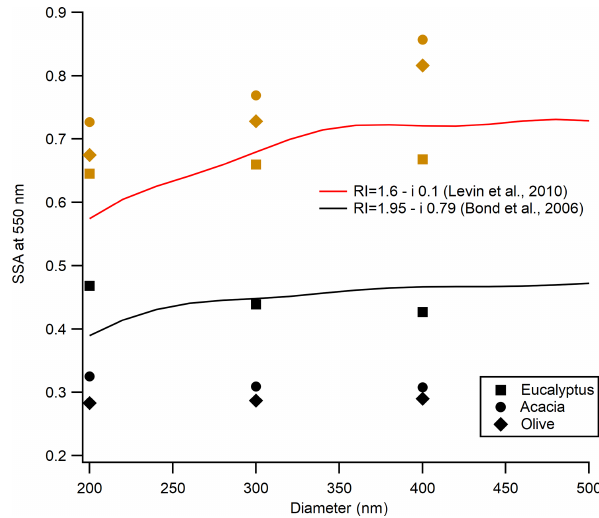
Figure 3. Impact of aerosol particle size on SSA. The solid red line is modeled SSA using Mie theory with the refractive index from Levin et al. (2010), representing typical BB emissions, and the black line is modeled SSA by Mie theory using the refractive index from Bond and Bergstrom (2006), representing black carbon. Neither line is a fit to the data. Symbols are the different fuel types represented in the legend, with black for flaming-dominated combustion and brown for smoldering-dominated